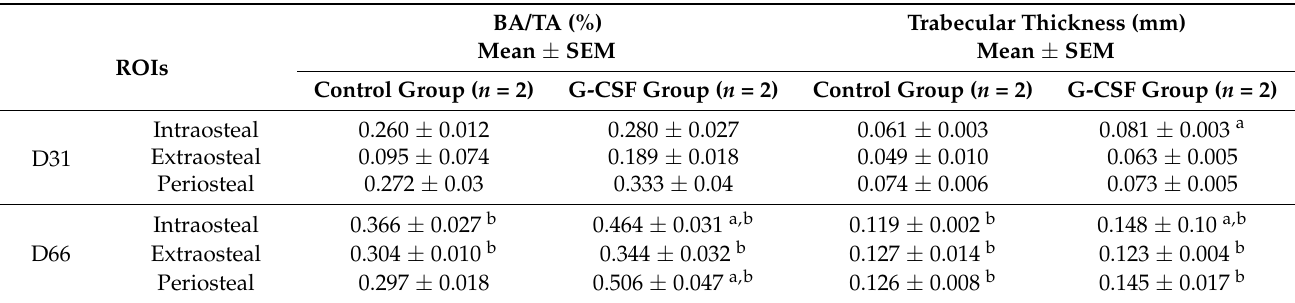
Table 1. Histological evaluation: area fraction (BA/TA) and 2D trabecular thickness. Values are given as mean ± SEM. Compared to control group, a p <0.05; compared to D31, b p <0.05.